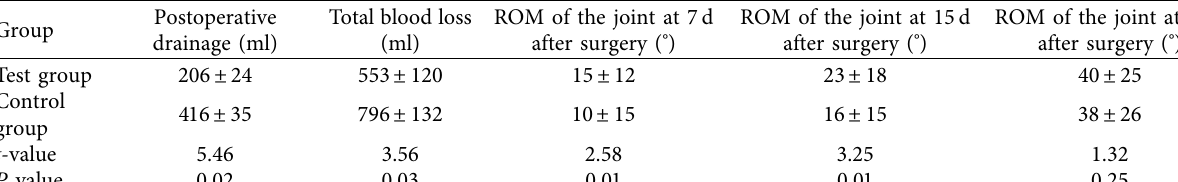
Table 4: Joint function assessment and blood loss of the two groups.